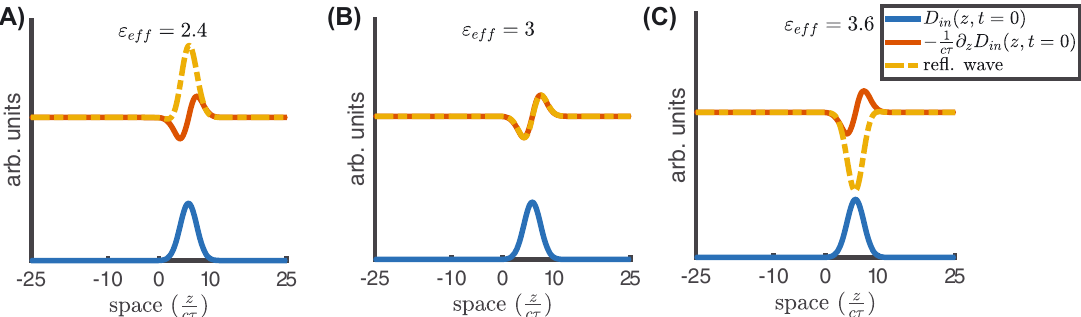
= 3, 1 ( z , t = 0) (red). in